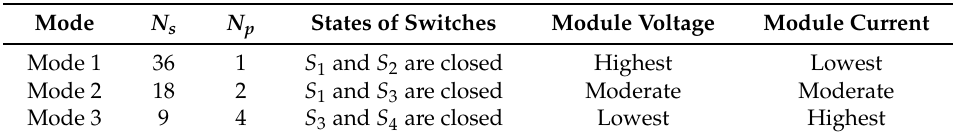
Table 1. Module characteristics at different